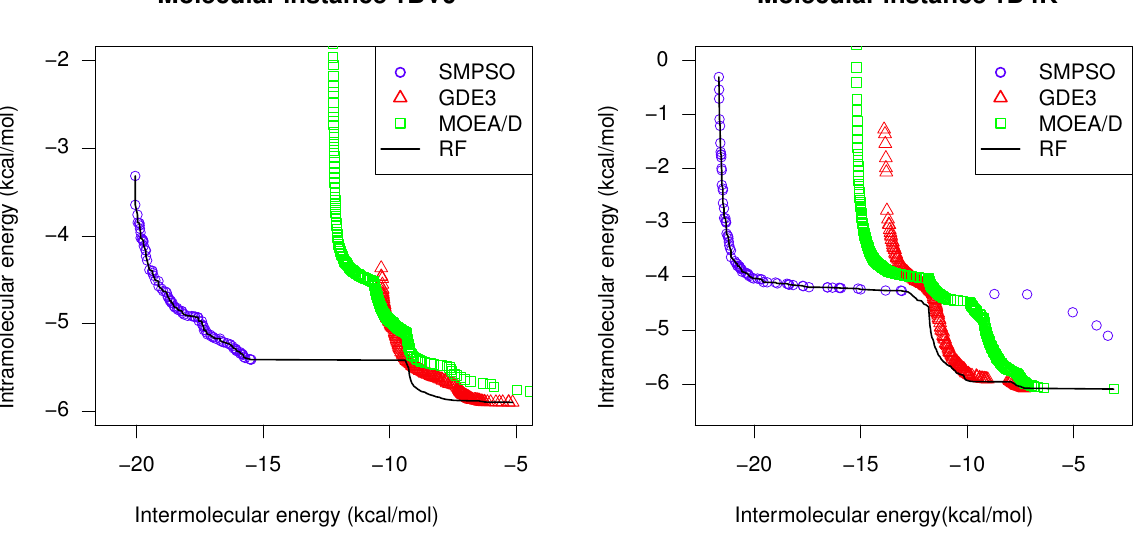
Figure 3. Reference fronts and best hyper-volumes from SMPSO, GDE3 and MOEA/D for instances 1BV9 and